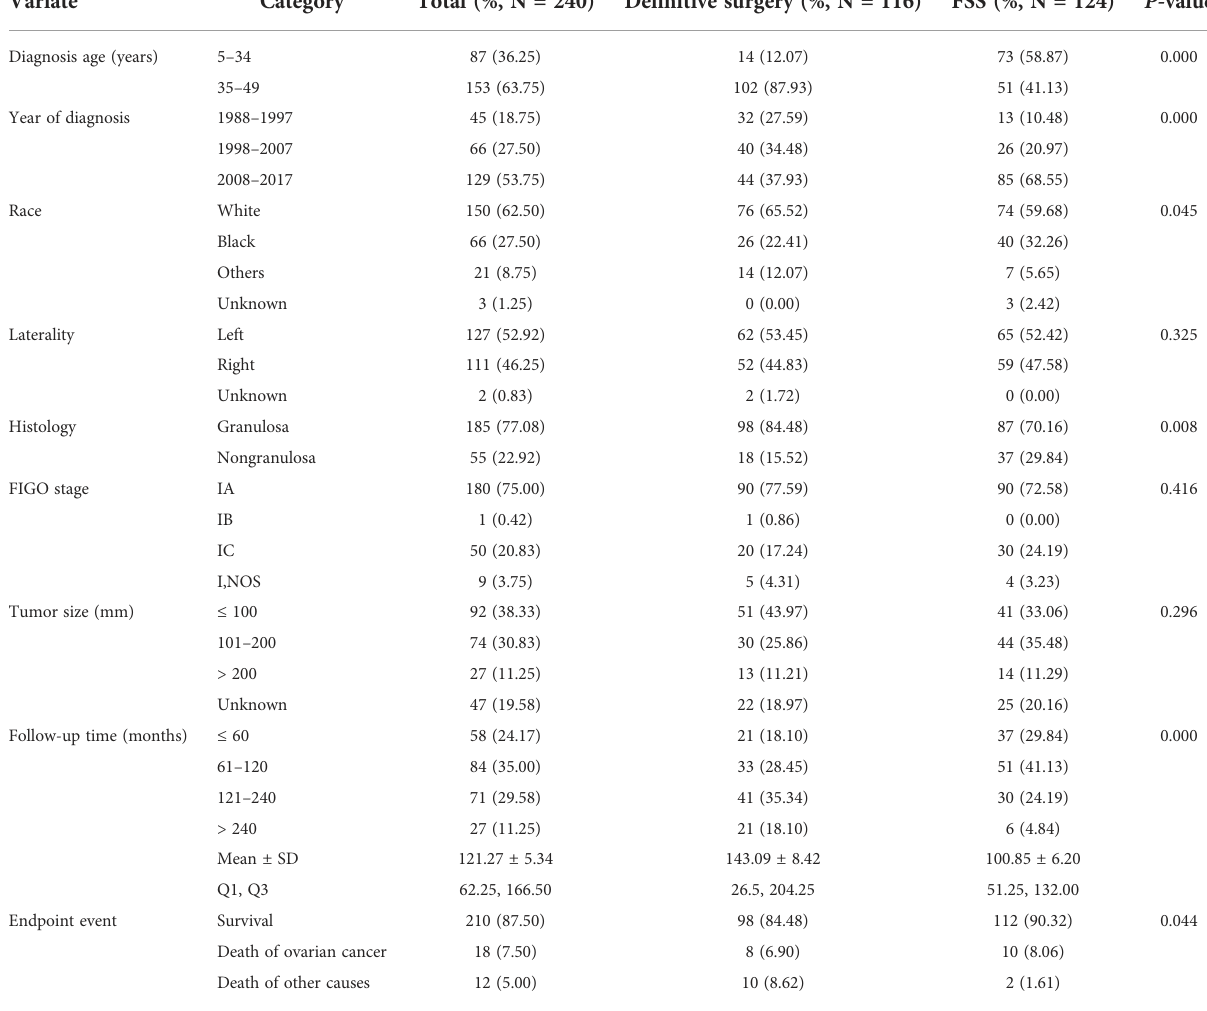
FSS, fertility-sparing surgery; FIGO, International Federation of Gynecology and Obstetrics; NOS, not otherwise speci fi